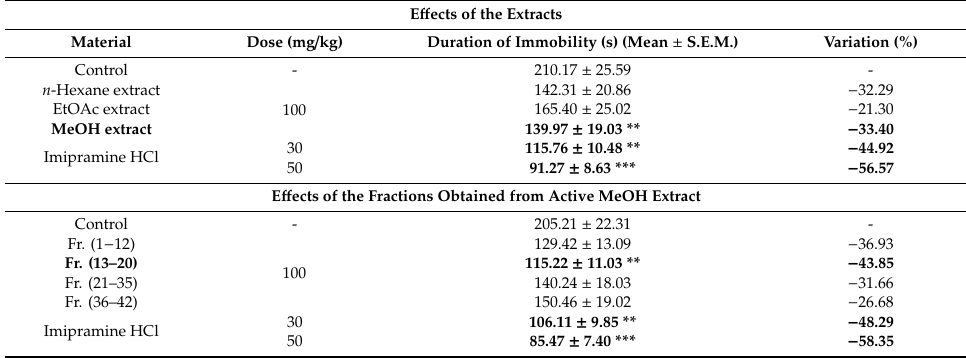
Table 2. E ff ects of the extracts and fractions prepared with organic solvents from Lotus corniculatus L. subsp. corniculatus in the forced swimming test.